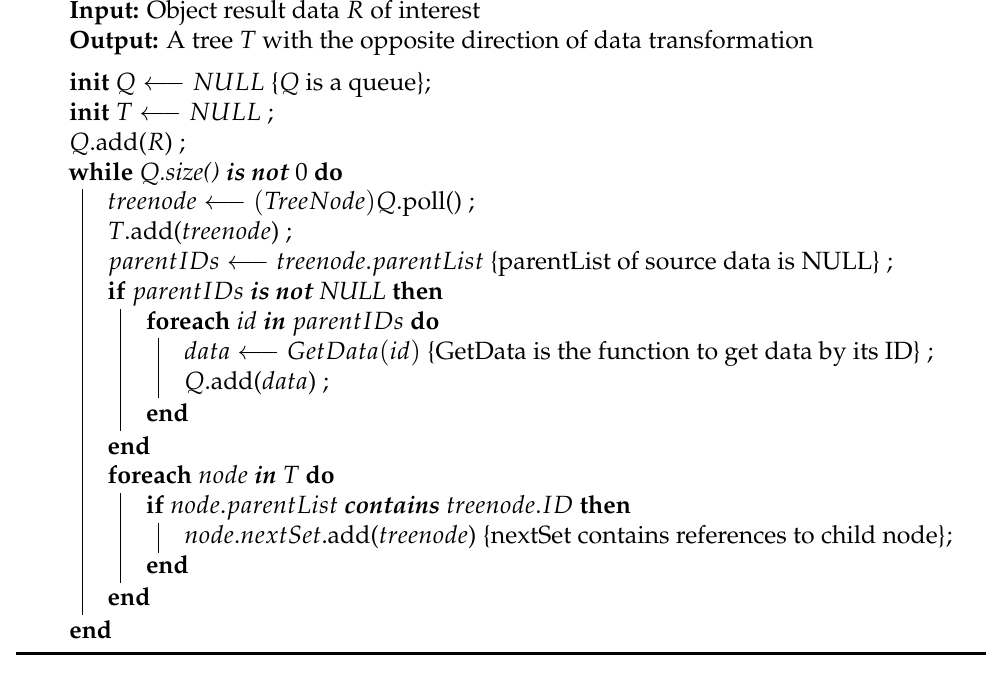
Algorithm 4: Provenance Querying Algorithm in Offline Phase